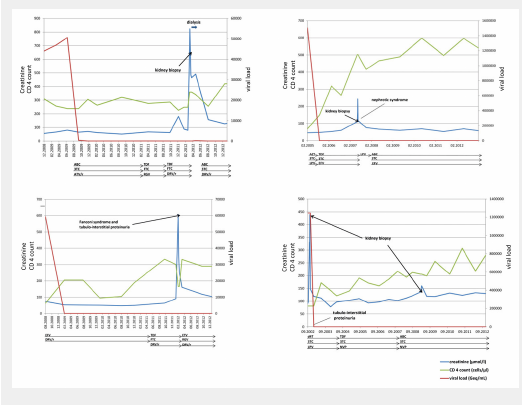
The individual courses of patients 2, 4, 9 and 10. Dialysis, the presence of tubulointerstitial proteinuria and kidney biopsies are indicated by arrows. 3TC = lamivudine; ABC = abacavir; EVF = efavirenz; ATV/ = atazanavir/ritonavir; d4T = stavudin; DRV/r = darunavir/ritonavir; FTC = emtricitabine; LPV/r = lopinavir/ritonavir; NVP = nevirapine; RGV = raltegravir; TDF = tenofovir disoproxil